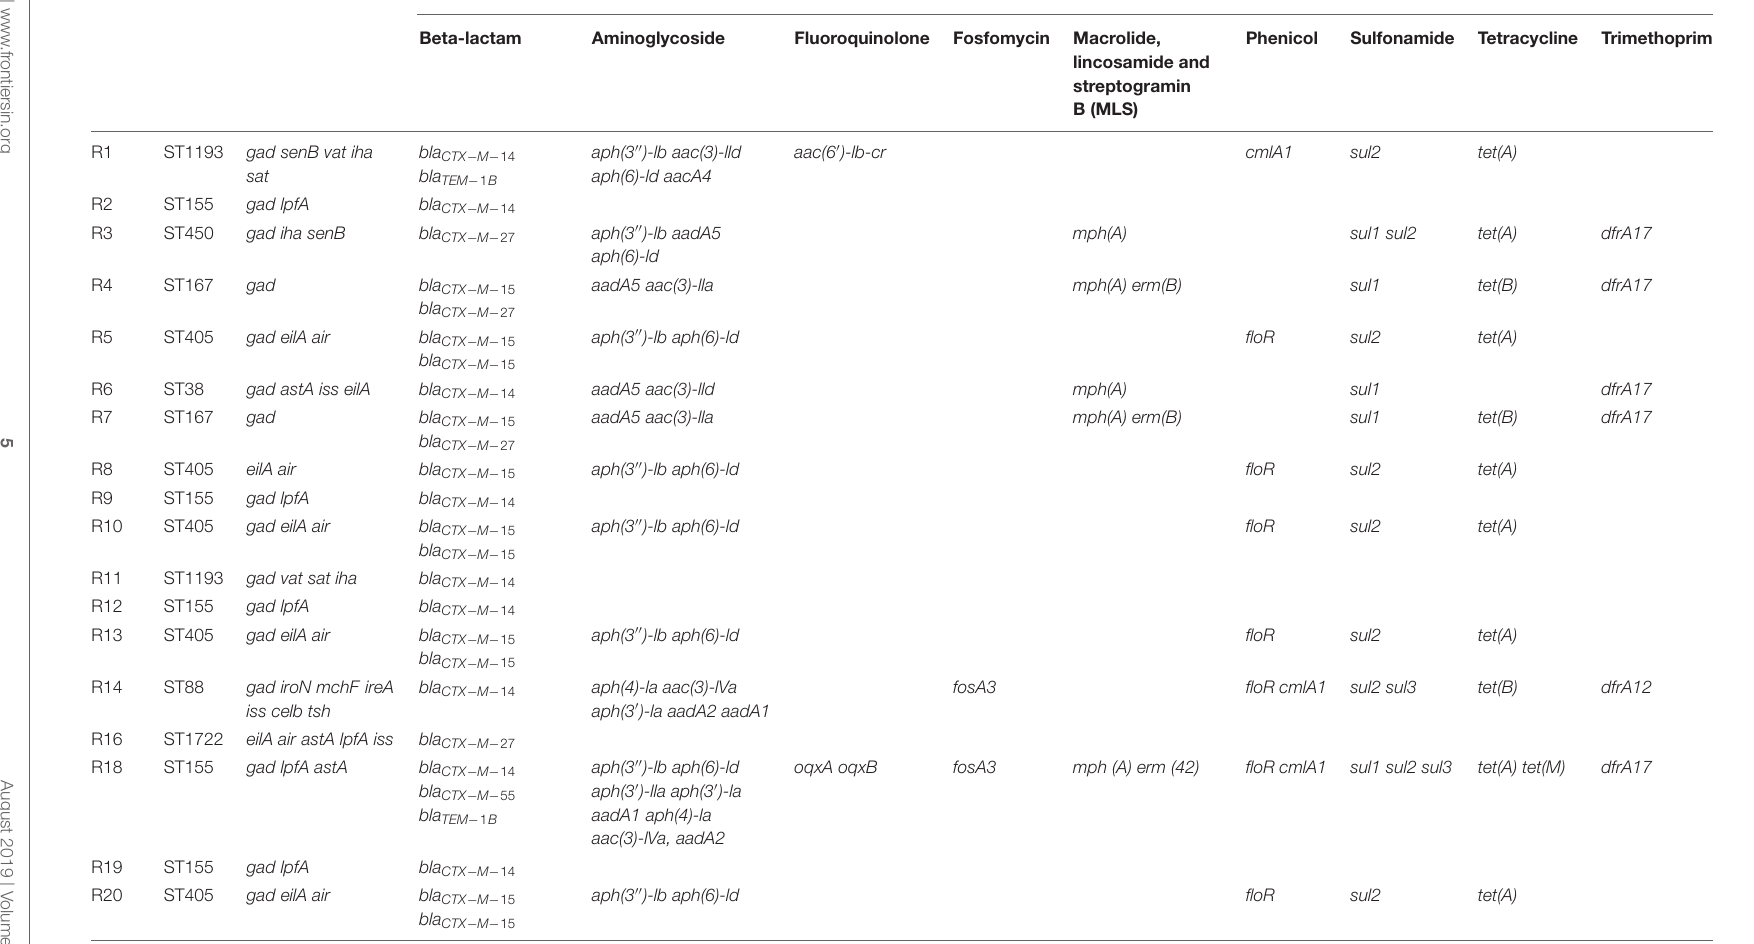
TABLE 2 | ARGs and virulence genes identified in the genomes of E. coli